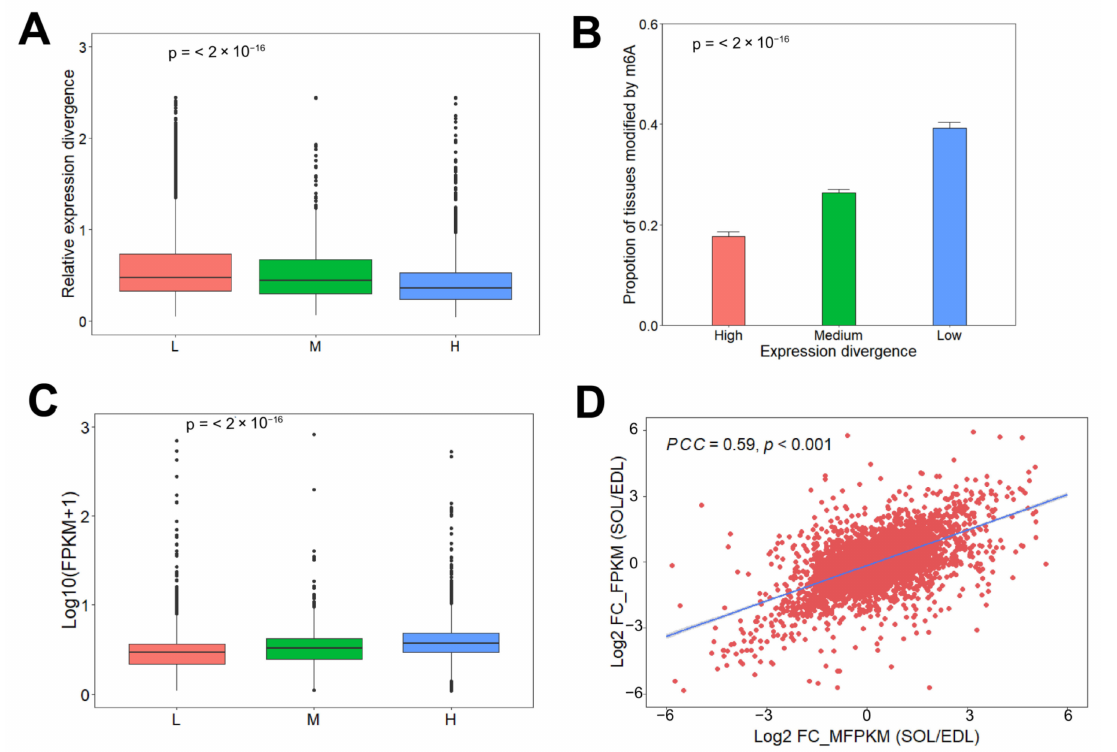
Figure 5. Association analysis of m 6 A with lncRNAs expression. ( A ) Relative expression diver- gence of lncRNAs in the L set (4596 lncRNAs), M set (639 lncRNAs) and H set (1534 lncRNAs). Significance was evaluated by a two-sided Mann–Kendall trend test, p < 2.2 × 10 − 16 . ( B ) The lncR- NAs were clustered into Low (1693 lncRNAs), Median (3383 lncRNAs), and High (1693 lncRNAs) groups according to the quantile of the expression divergence. Significance was evaluated by a two-sided Mann–Kendall trend test, p < 2.2 × 10 − 16 . ( C ) Expression level in lncRNAs in the L set (4596 lncRNAs), M set (639 lncRNAs) and H set (1534 lncRNAs). Significance was evaluated by a two-sided Mann–Kendall trend test, p < 2.2 × 10 − 16 . ( D ) Scatter plot showing the positive correlation between m 6 A levels and expression level of lncRNAs between EDL and SOL. FC: Fold change; PCC: Pearson correlation